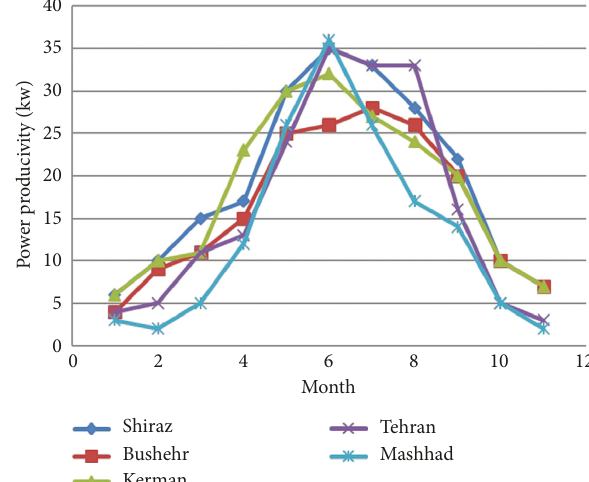
Figure 8: Average changes in power plant production power in different months of the year for selected